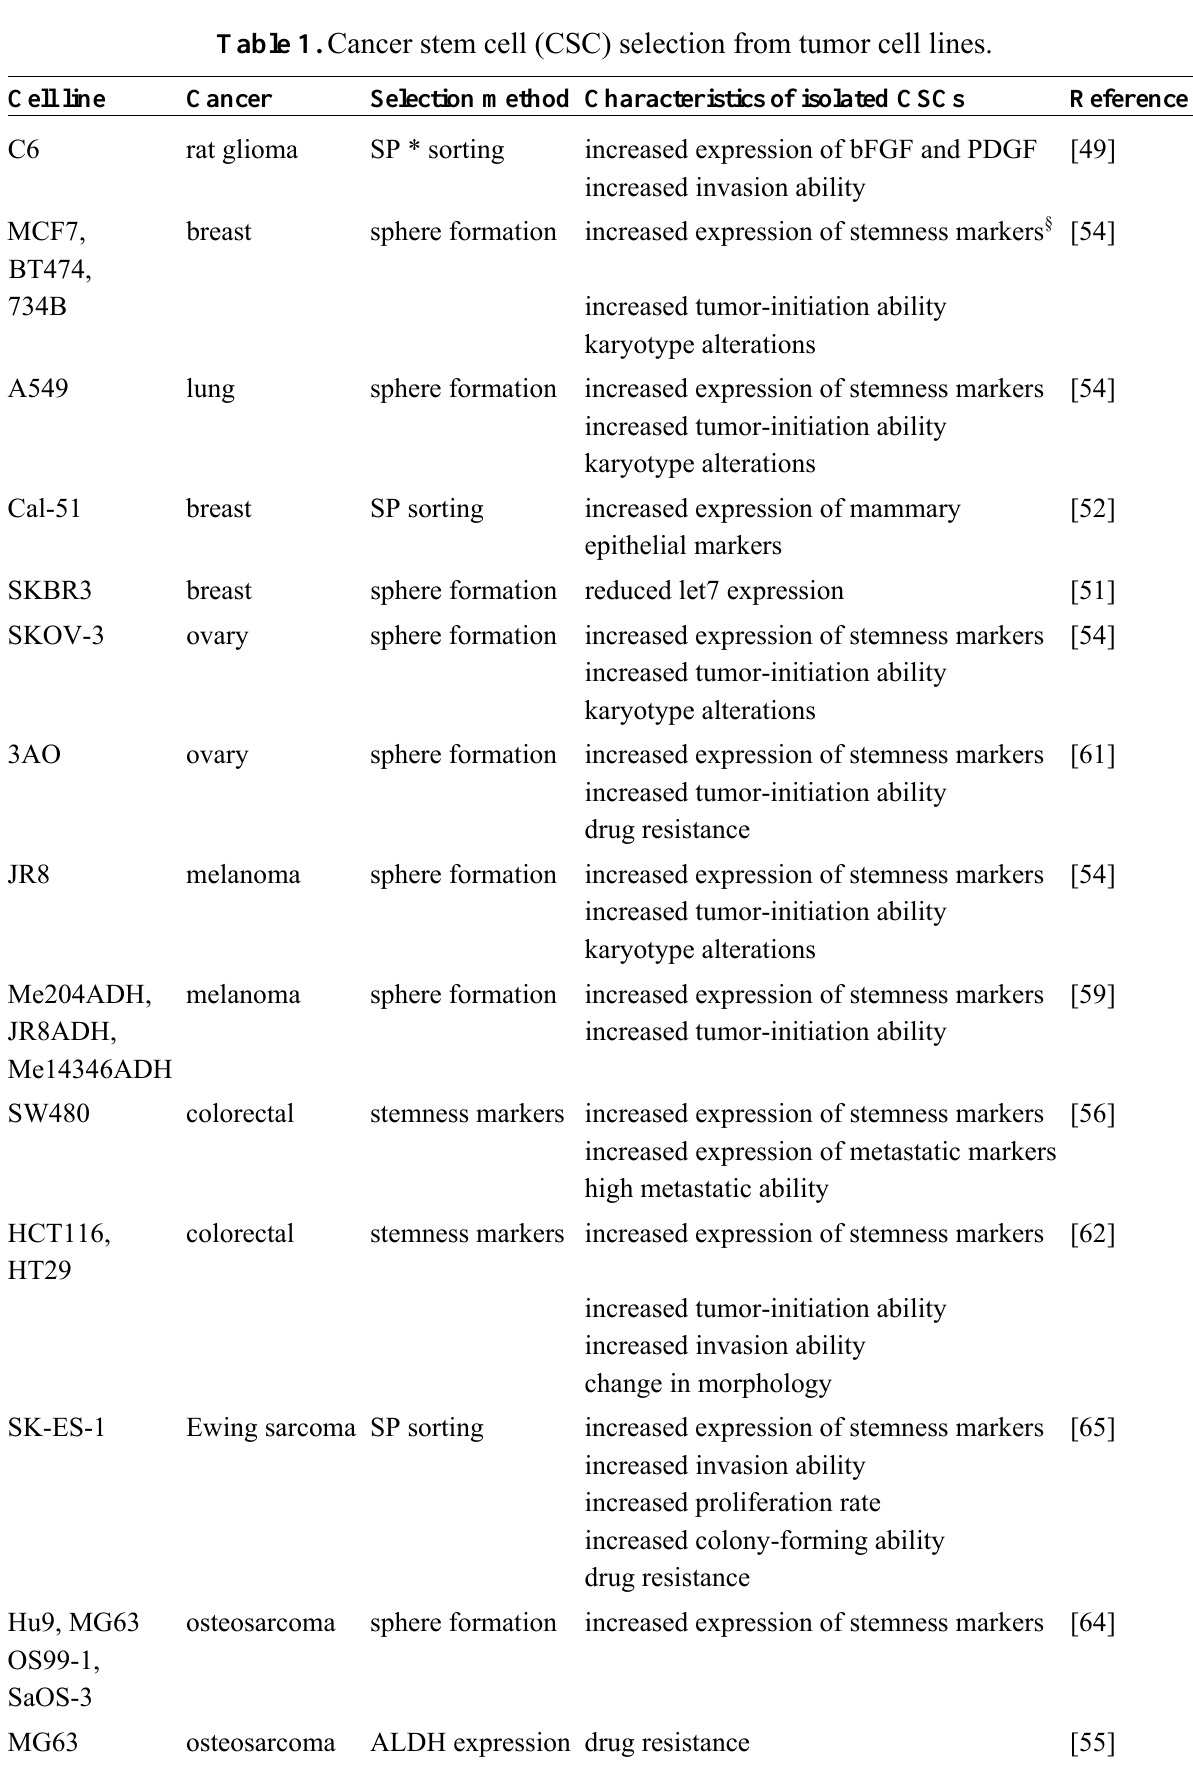
Table 1. Cancer stem cell (CSC) selection from tumor cell